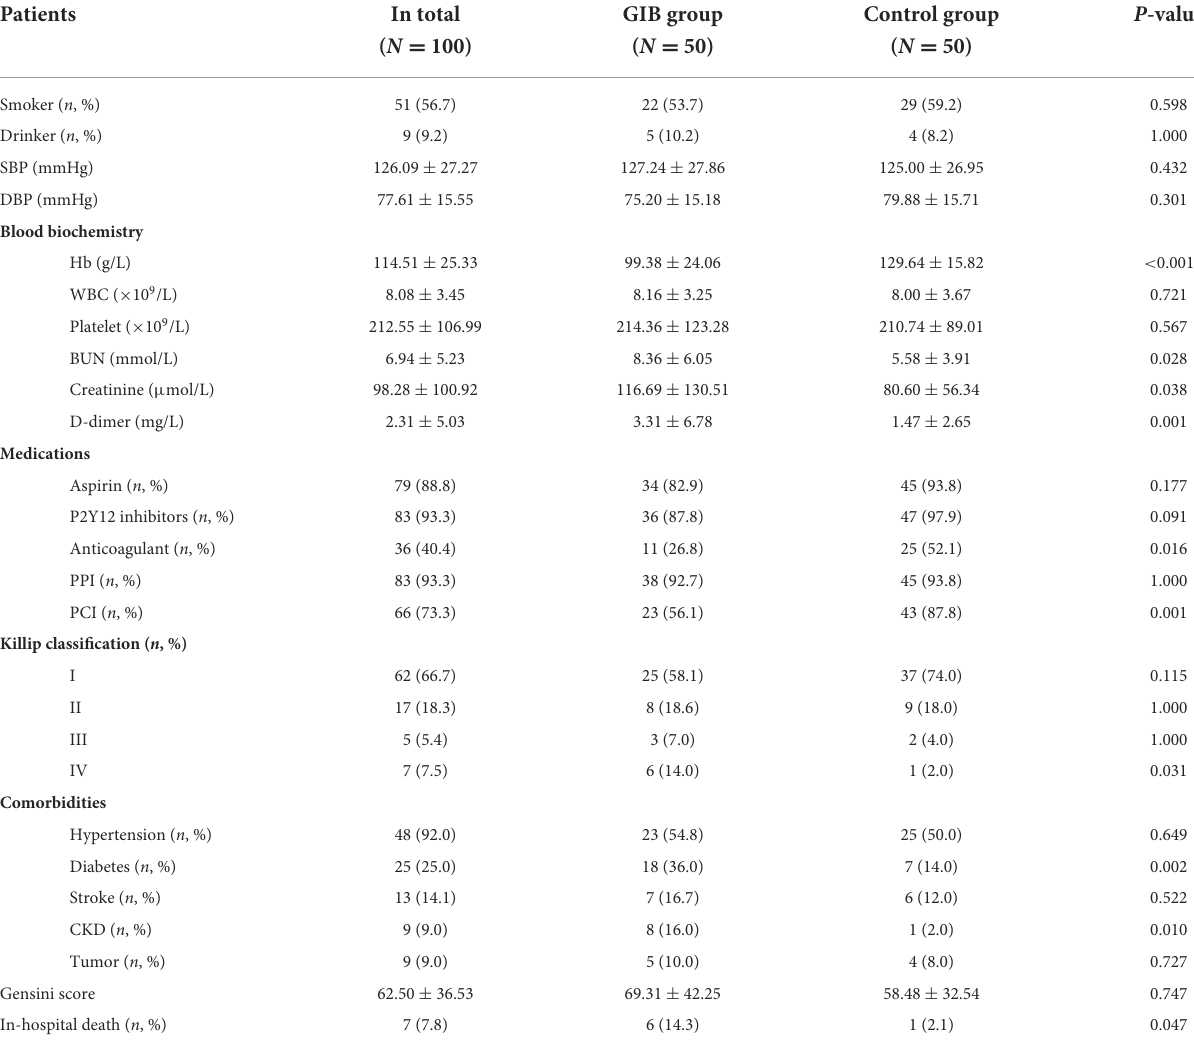
TABLE 2 Differences in demographic and clinical characteristics of AMI patients with and without in-hospital GIB.